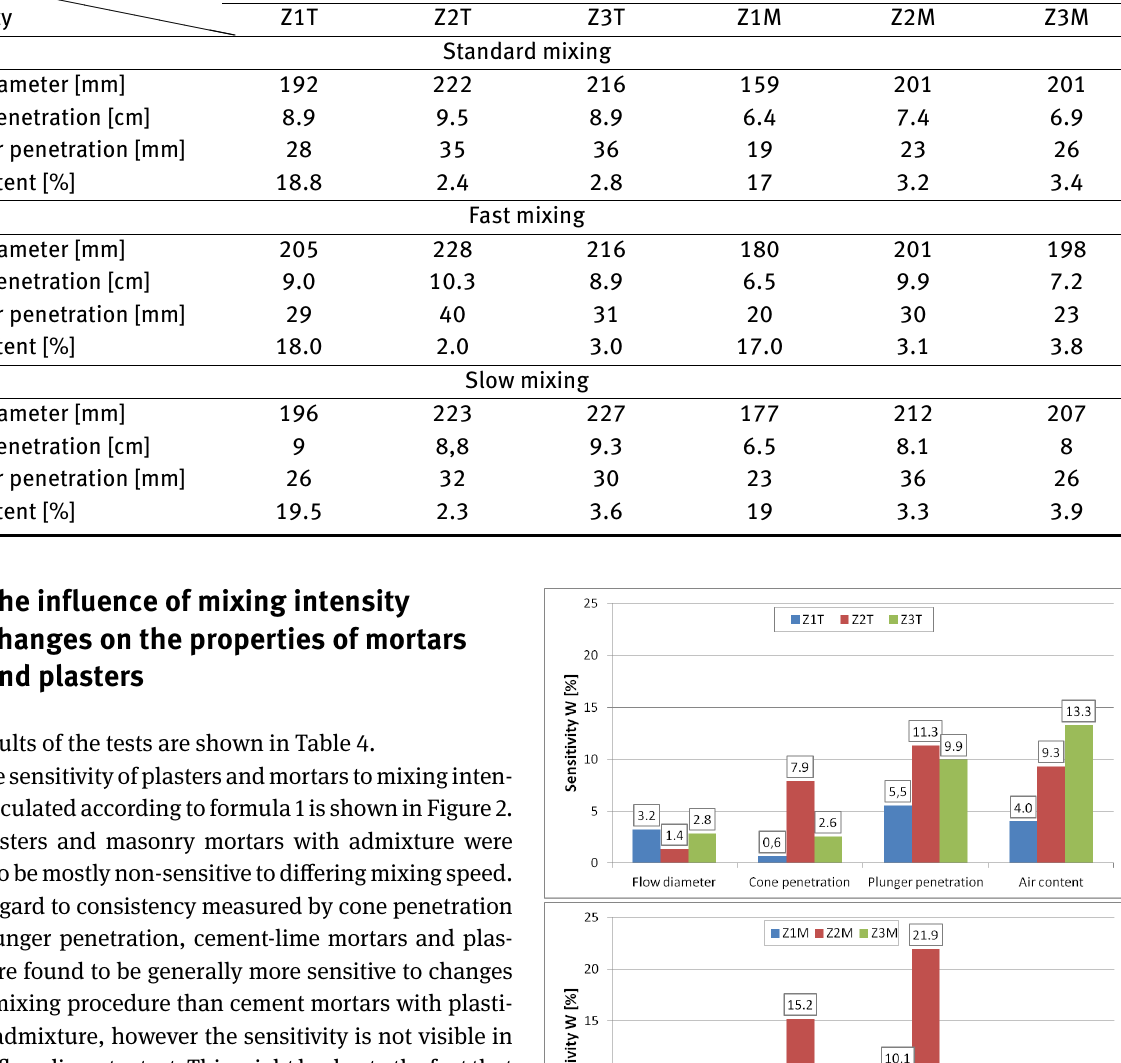
Table 4: Results of the tests of plaster and mortars mixed by 3 different intensities of mixing procedure. (cid:96)(cid:96)(cid:96)(cid:96)(cid:96)(cid:96)(cid:96)(cid:96)(cid:96)(cid:96)(cid:96)(cid:96)(cid:96)(cid:96) Property